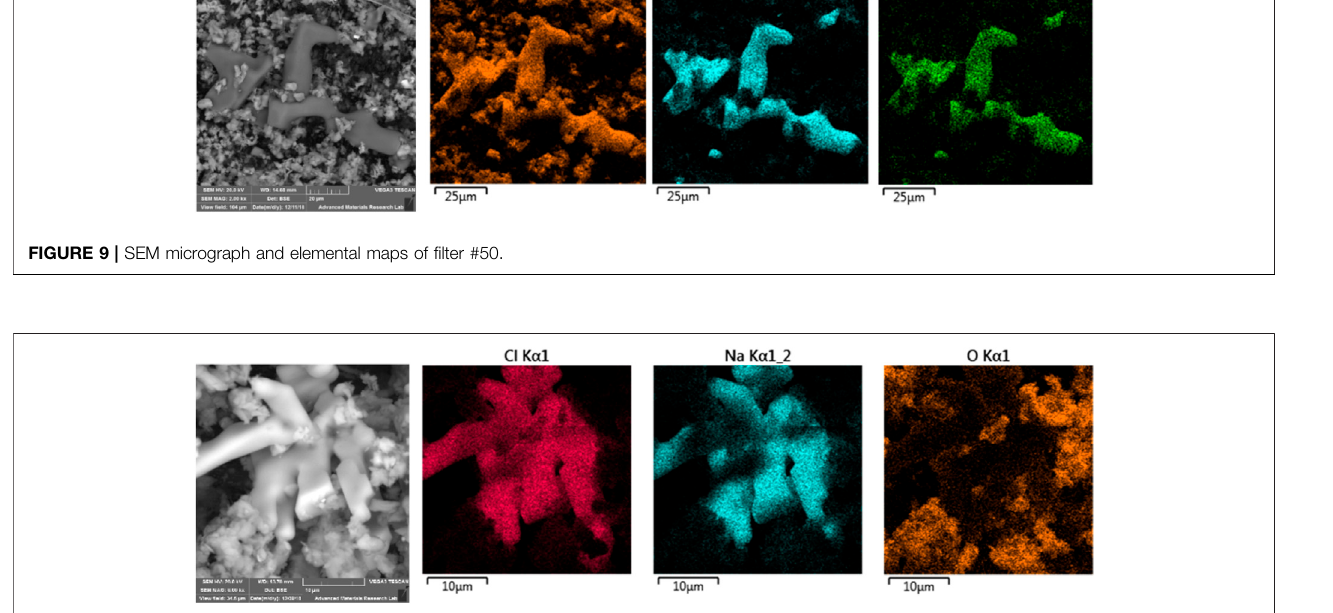
FIGURE 10 | SEM micrograph and elemental maps of sample #8, showing large halite